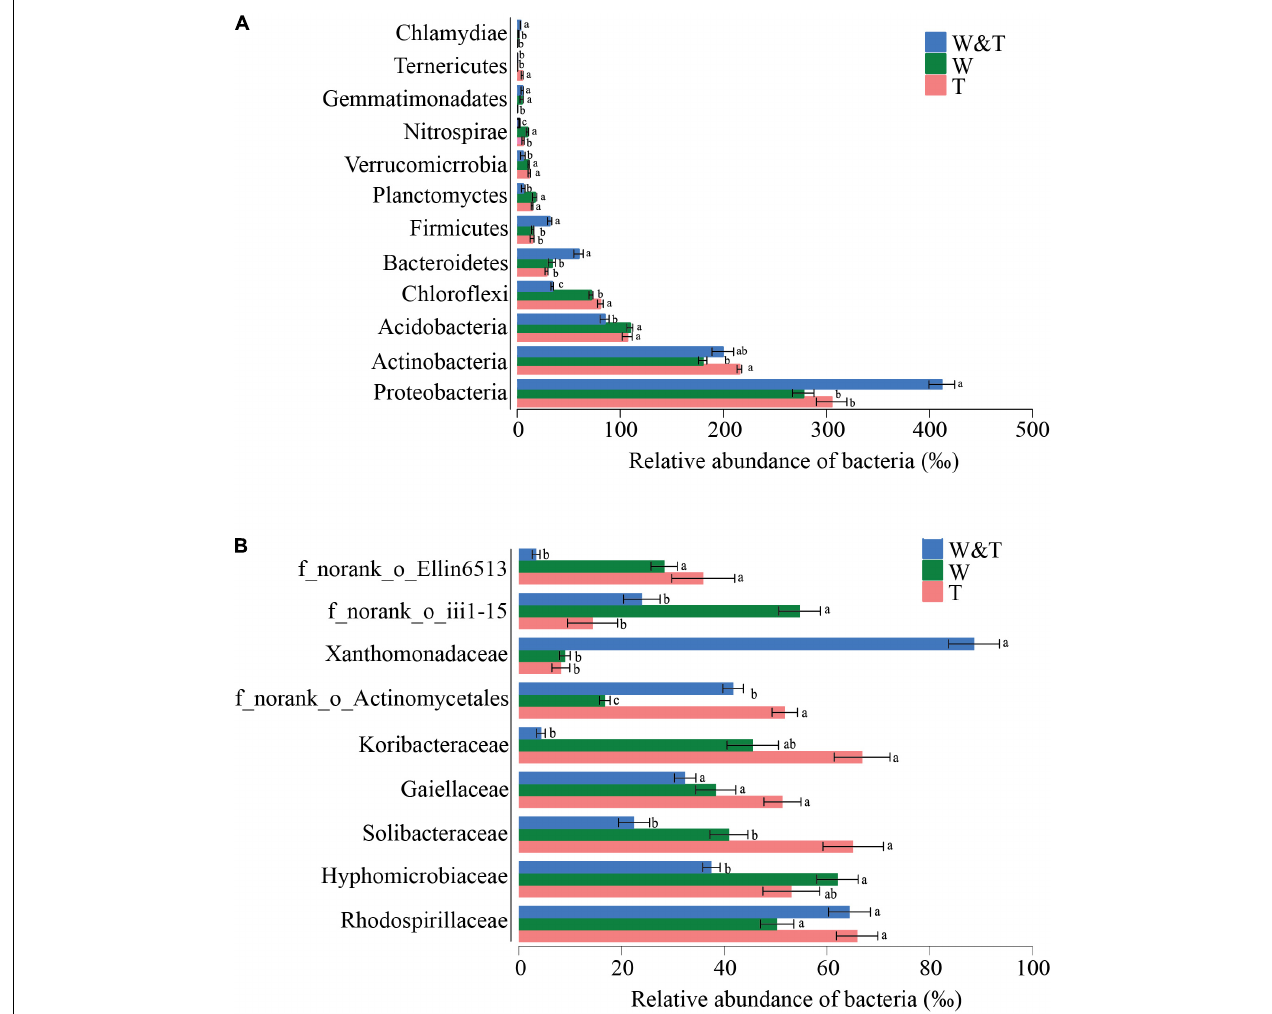
FIGURE 4 | Average relative abundance (RA) of the most dominant bacterial phyla and families in the monoculture tea forest (T), monoculture walnut forest (W), and walnut–tea intercropping forest (W&T). (A) RA of bacterial communities at the phylum level. (B) RA of bacterial communities at the family level. Only operational taxonomic units (OTUs) with RA > 1% in at least one sample were included in the analysis. Different lowercase letters on each bar indicate the least significant differences (LSDs; p < 0.05) among T, W, and W&T